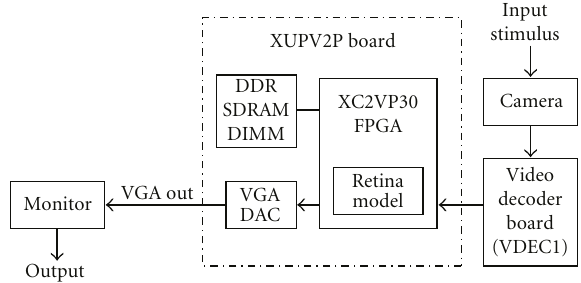
Figure 7: XUPV2P-based experimental system. Table 1: General single-channel retina model requirements and available resources on di ff erent